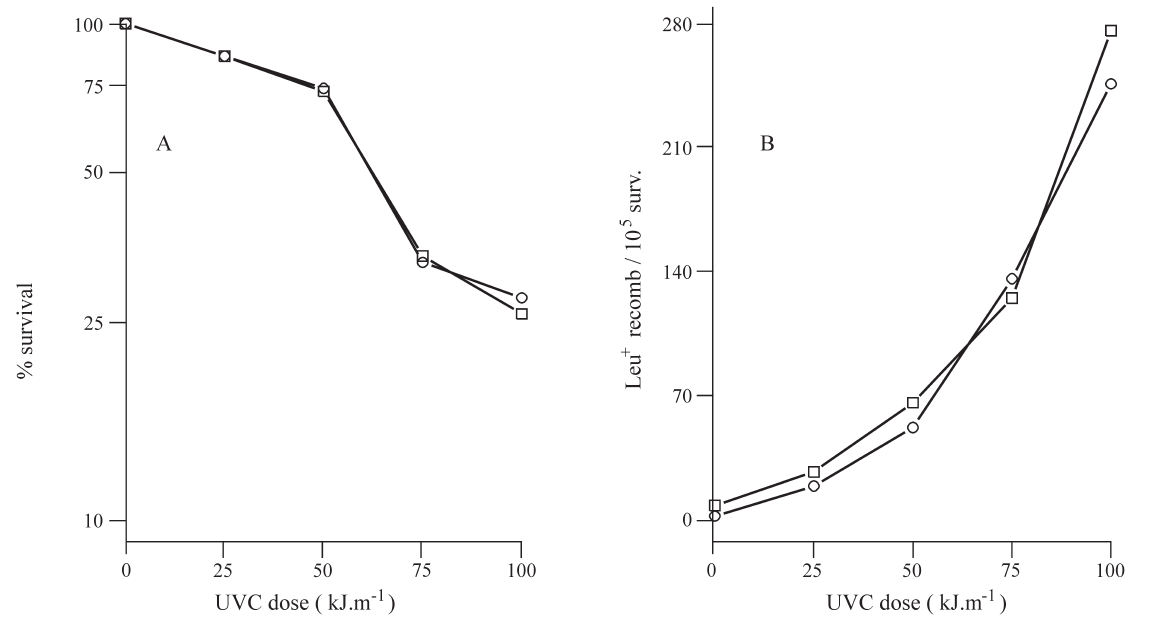
Figure 2 - Effect of UVC (254 nm) treatment on the percentage cell survival (Figure A) and gene conversion rate (Figure B) of stationary phase mitotic diploid yeast cells harboring the recA gene, symbols as in Figure 1.